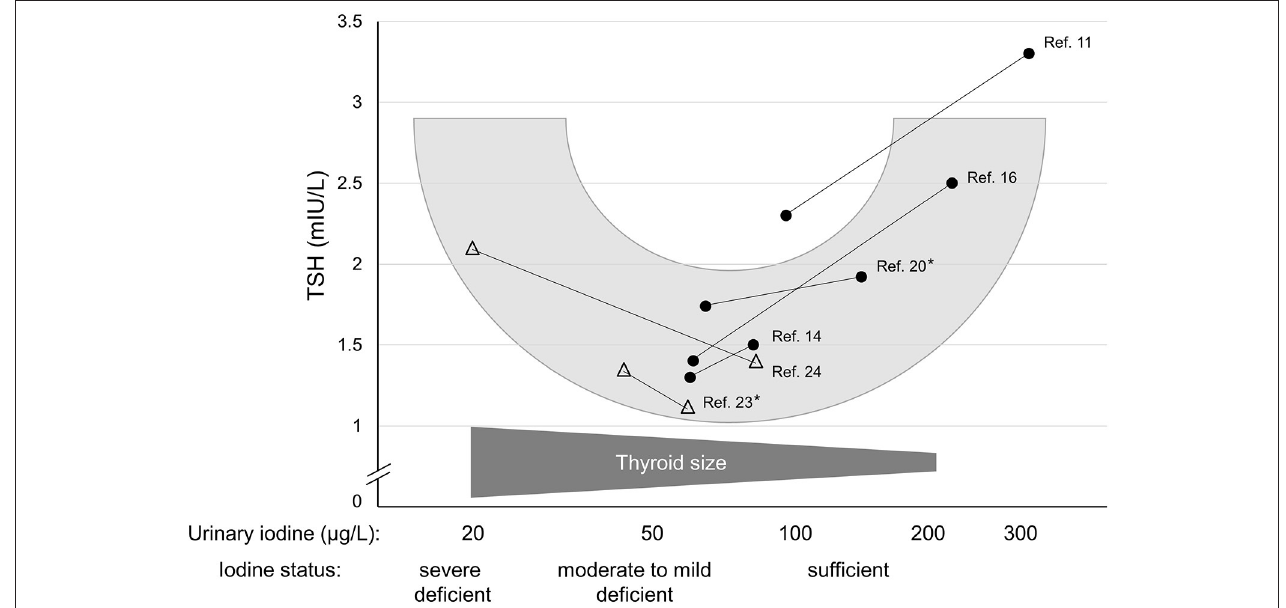
FIGURE 1 | Schematic representation of the probable U-shaped relationship between circulating TSH and iodine nutritional status (urinary iodine, logarithmized). The filled circles show median urinary iodine measurements and related TSH values of studies describing a mild iodine deficiency along with a situation of an (at least somewhat) improved iodine supply. Open triangles show a moderate or an almost severe iodine deficiency each along with an improved iodine status. Asterisks denote studies that have provided iodine measurements not as µ g/L, but as µ